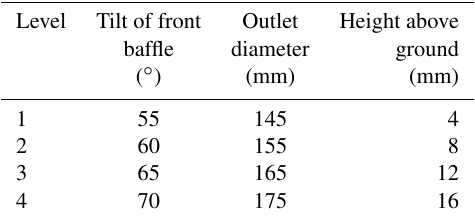
Table 2. Factor-level